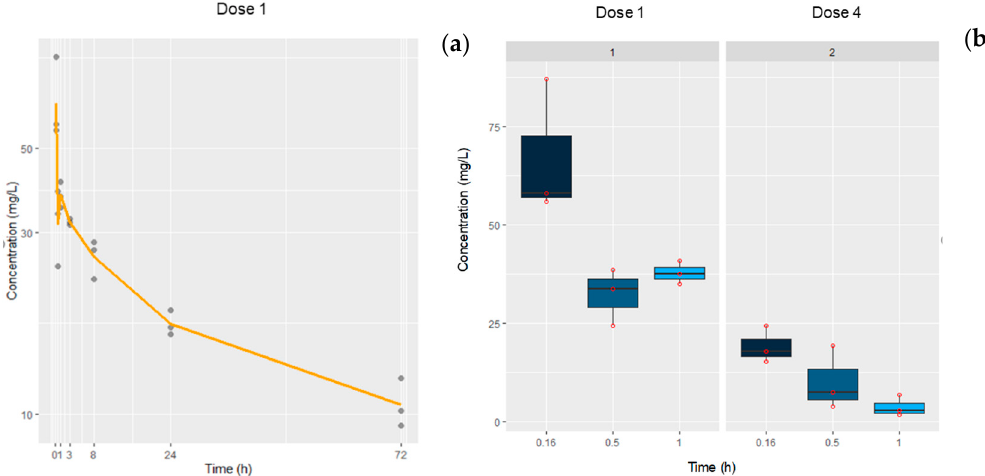
Figure 7. Pharmaceutics 2020 , 12 , x